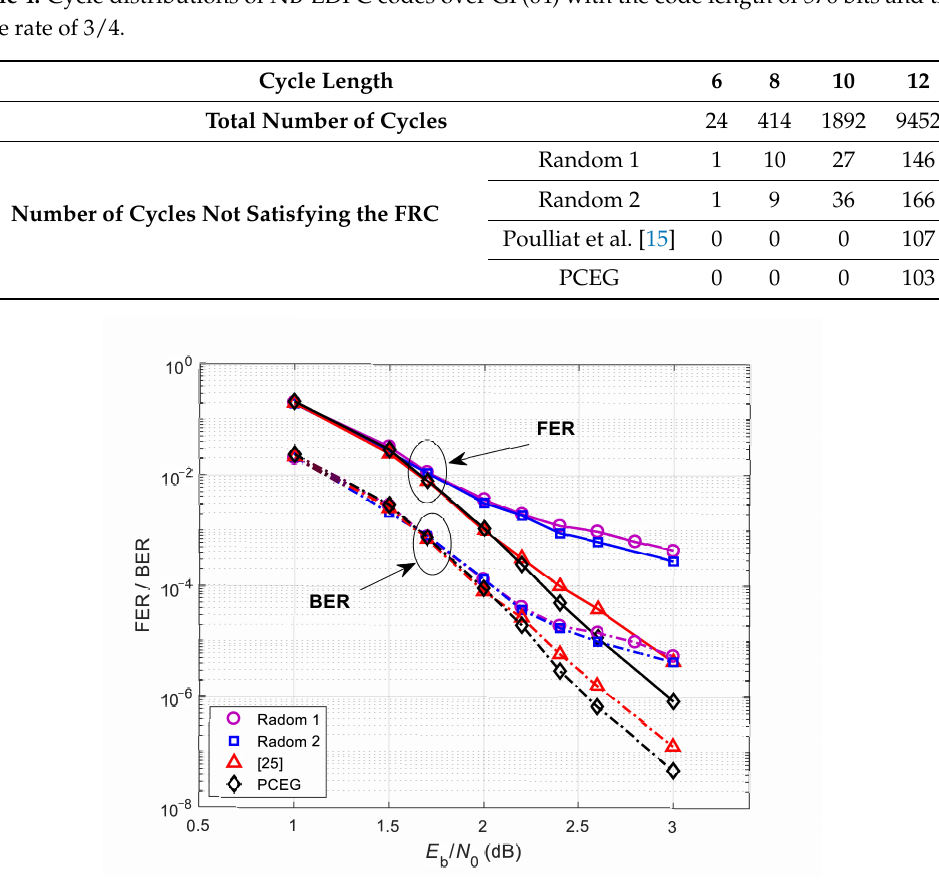
Figure 11. Performance of NB- LDPC codes over GF(64) with the code length of 576 bits and the code rate of